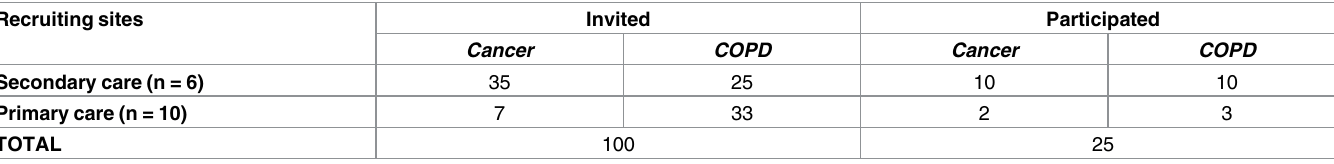
Table 1. Patient-carer dyad recruitment by diagnostic group and recruiting site